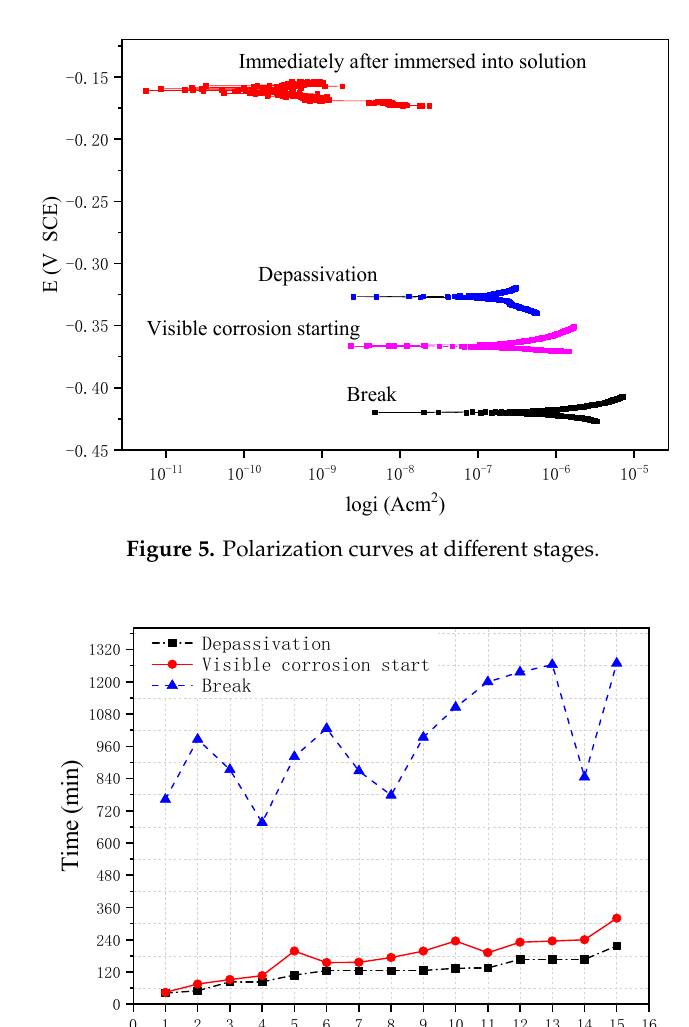
Figure 5. Polarization curves at different stages.